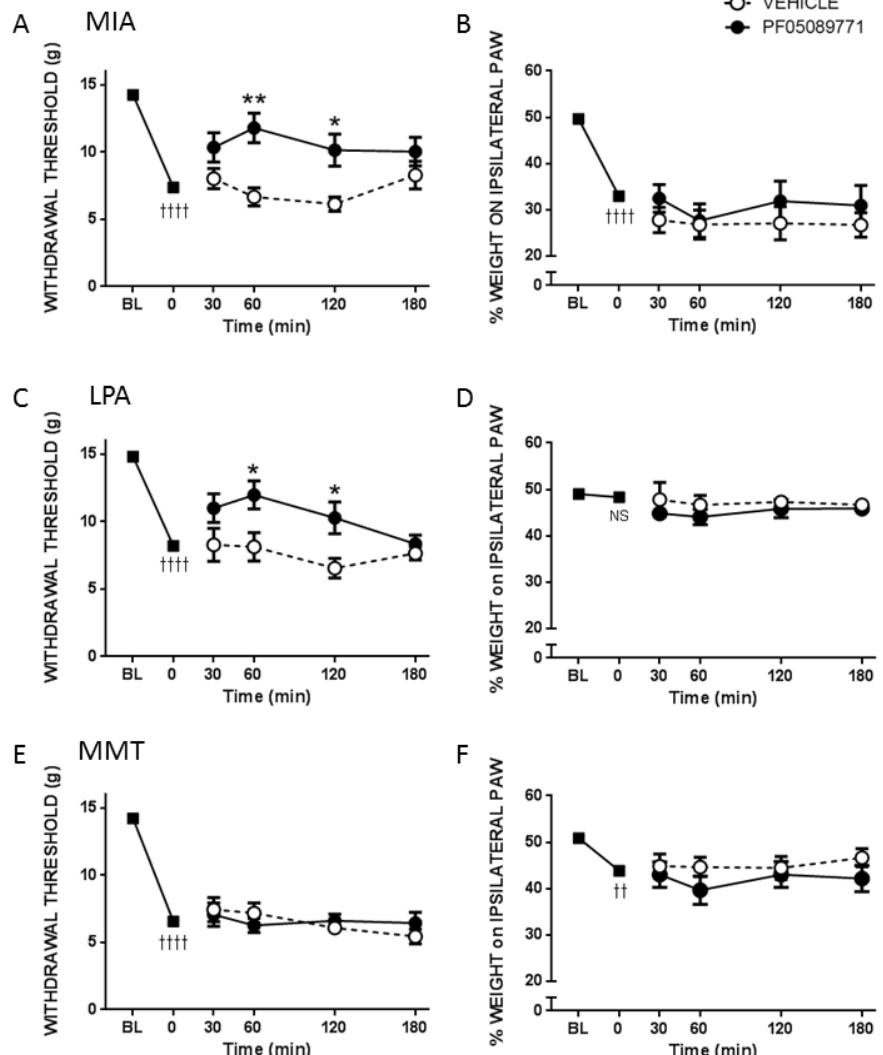
amount of weight borne on the ipsilateral hindlimb ( p < 0.0001, Figure 3B). Twenty-eight days after treatment of the knee with LPA, there was an observable drop (44.7 ± 3.8%) in withdrawal thresholds ( p < 0.0001, n = 7–8 animals/group, Figure 3C) but no significant change (1.1 ± 2.6%) in hindlimb weight bearing ( p = 0.4, Figure 3D). Surgical destabilisation of the joint by MMT surgery also produced a significant drop (53.1 ± 2.9%) in withdrawal threshold ( p < 0.0001, n = 11–13 animals/group, Figure 3E) but only a modest decrease (13.2 ± 3.9%) in weight bearing ( p < 0.01, Figure 3F).